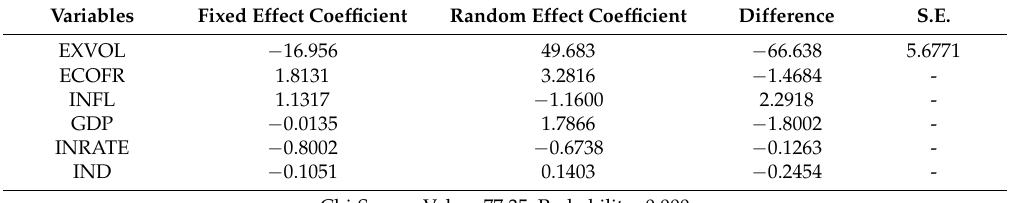
Table A7. Hausman Test: International Trade and Exchange Rate Volatility (GARCH).